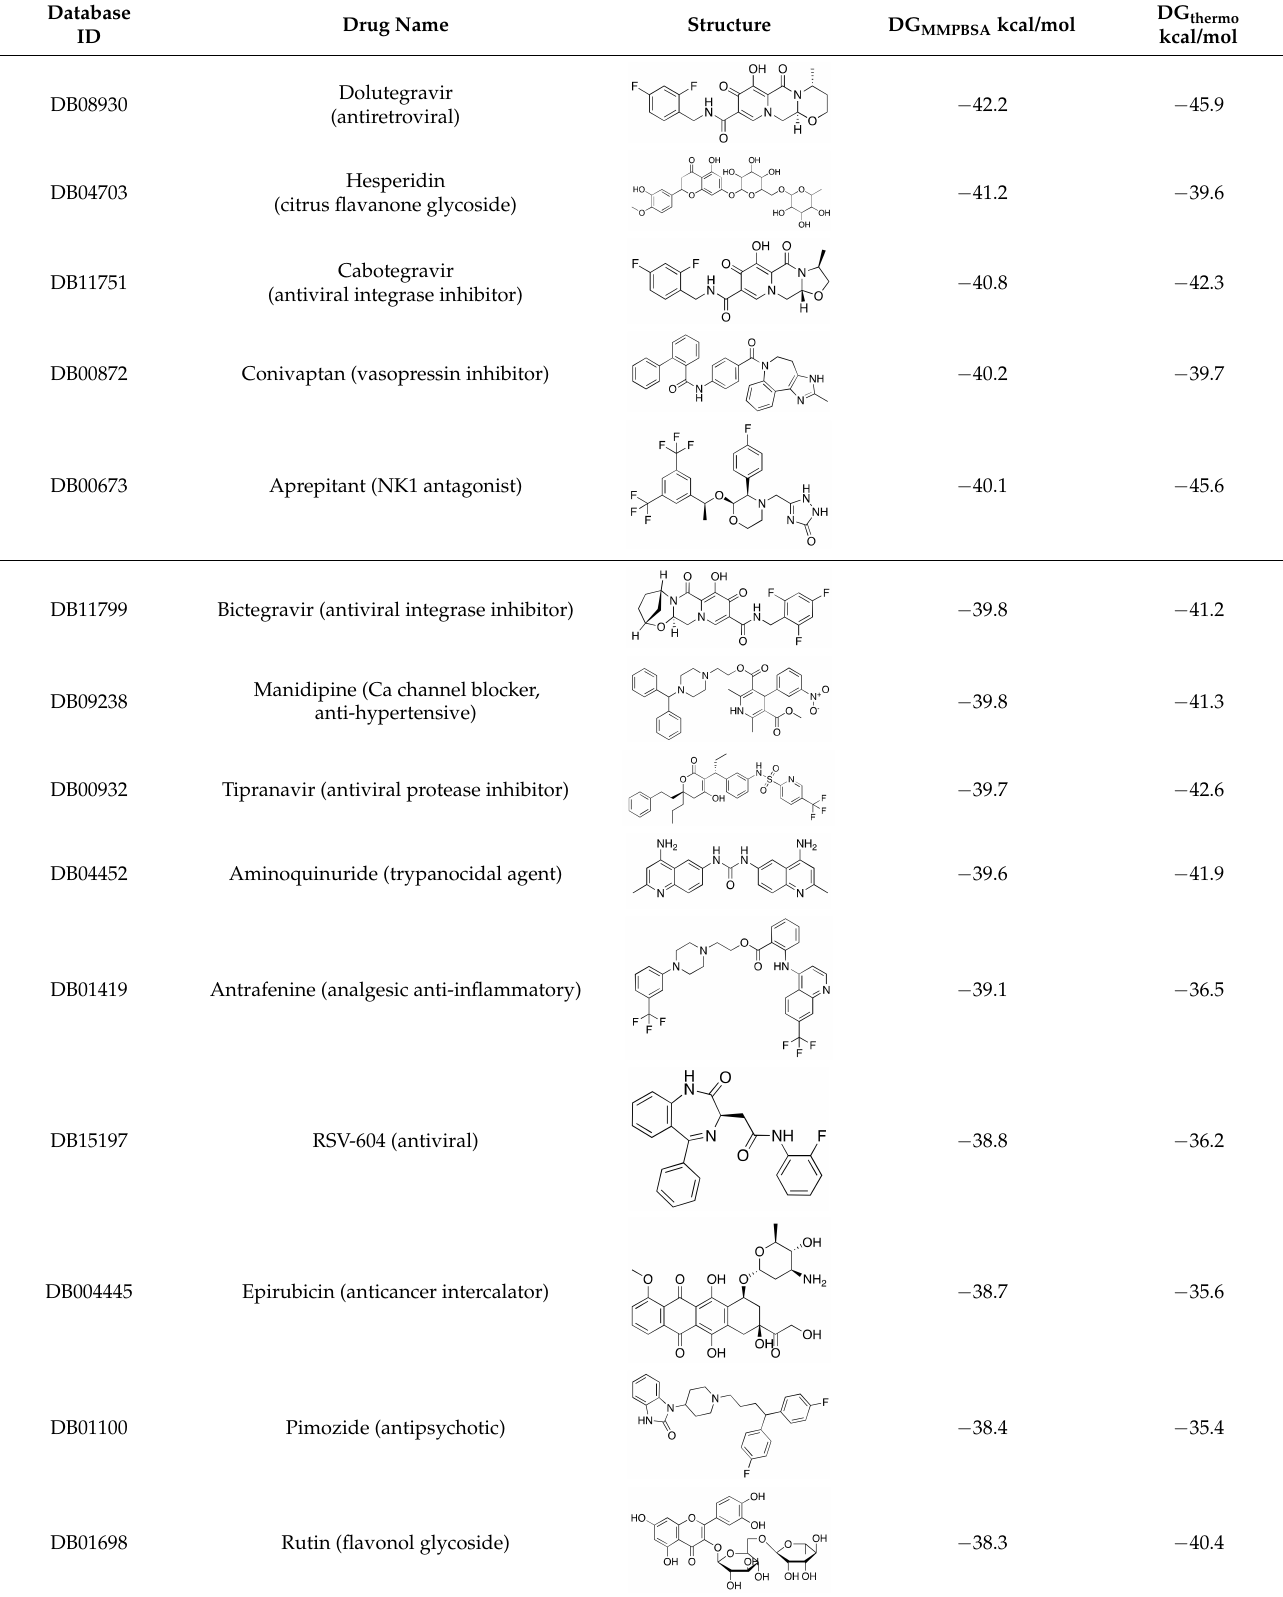
Table 1. Binding energies of top 20 hits (ranked by MMPBSA score) against SARS-CoV-2